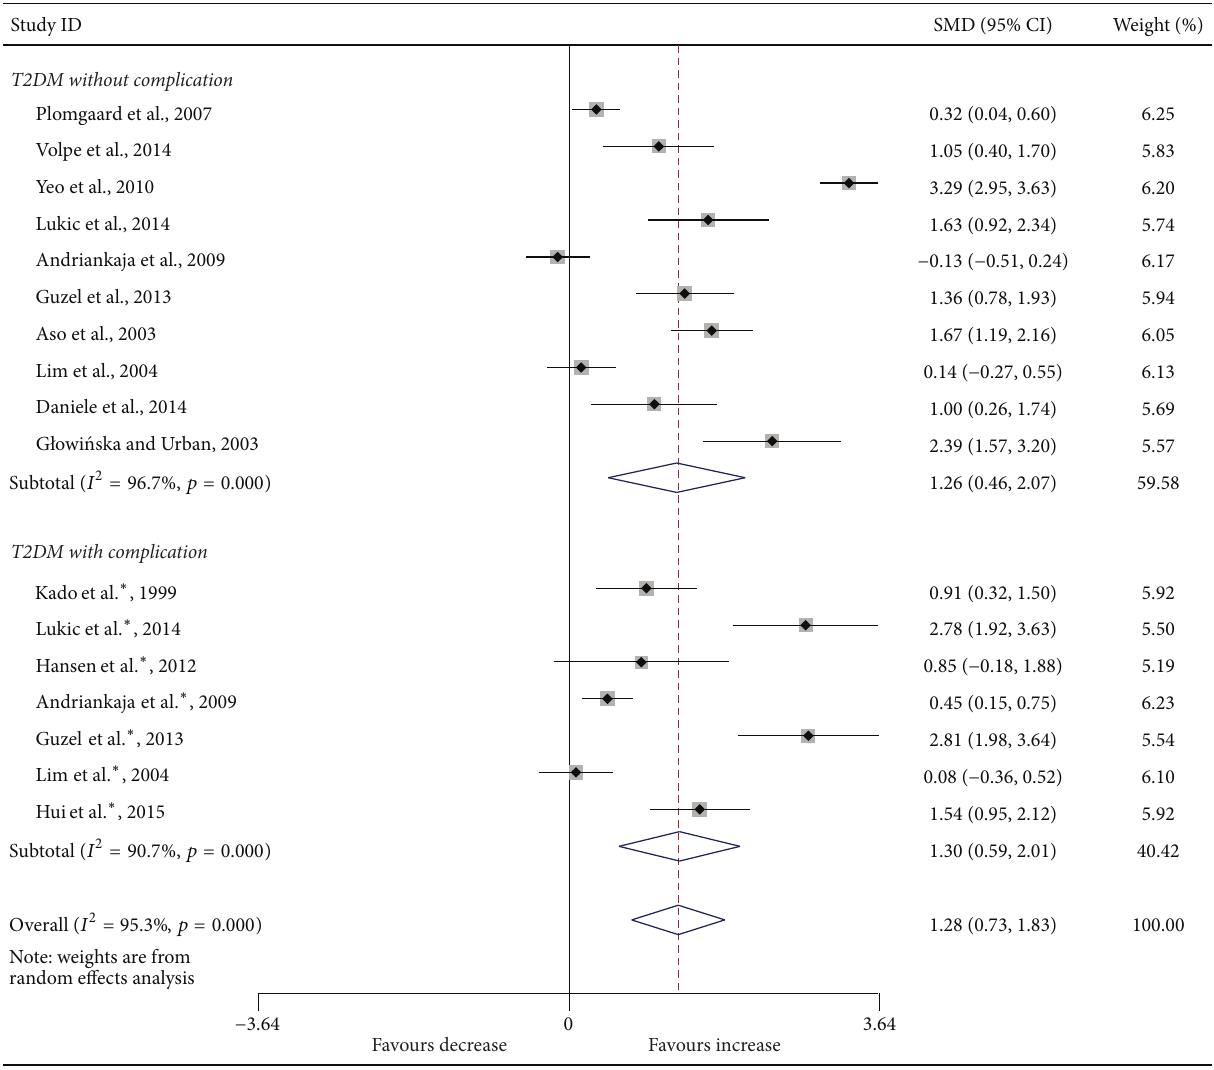
Figure 2: Forest plots for serum IL-6 in T2DM patients and controls with random effects model (T2DM without complication, 𝑝 = 0.002 ; T2DM with complication, 𝑝 < 0.001 ; overall, 𝑝 < 0.001 ). ∗ T 2 DM with